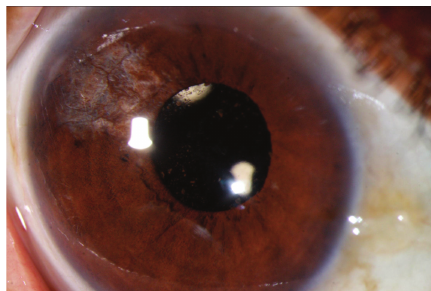
Figure 5: Postoperative slit lamp photograph showing minimally distorted pupil following pupil manipulation intraoperatively to negotiate posterior